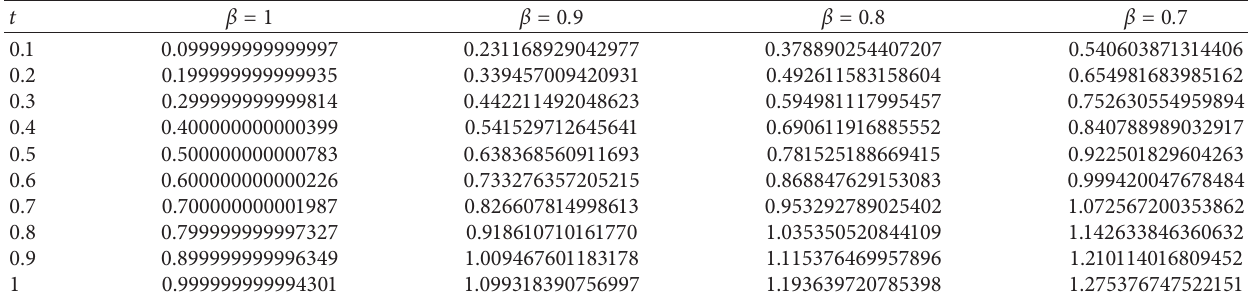
Table 3: The results are obtained for different fractional orders and N � 130.